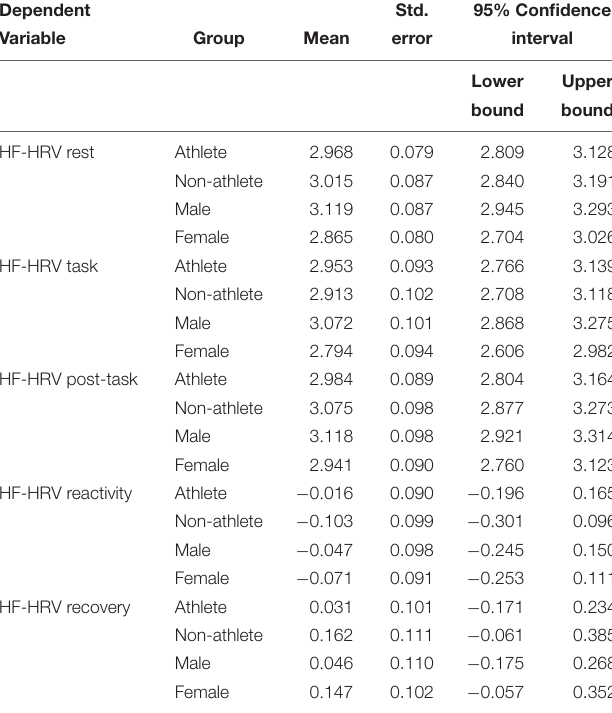
TABLE 4 | Estimated marginal means.